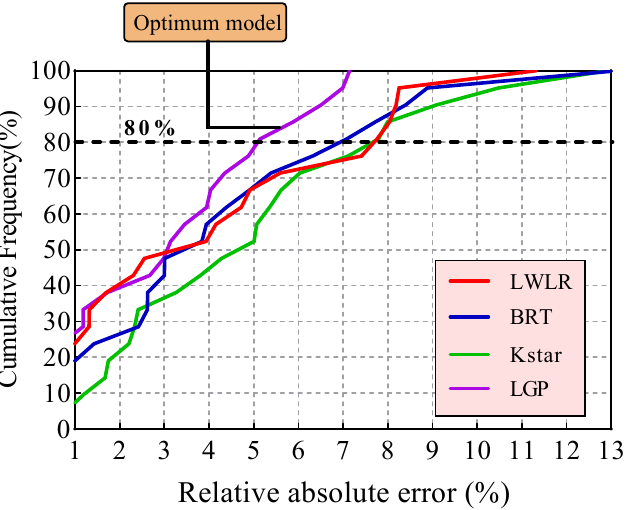
Figure 11. The cumulative frequency percentage versus the relative absolute error (%) for LWLR, BRT, KStar, and LGP models for the testing dataset.